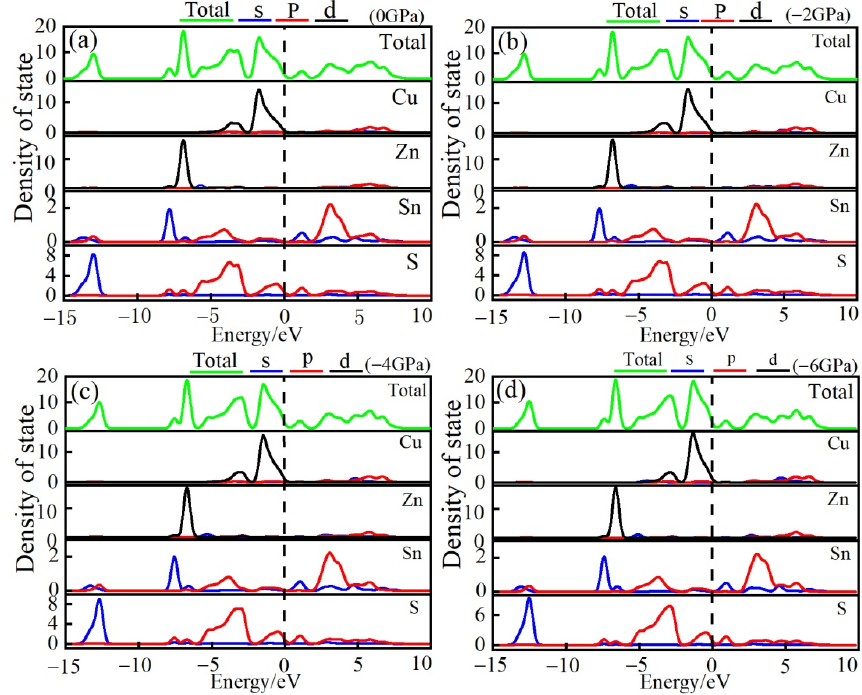
Figure 4. Cu 2 ZnSnS 4 density of states under tensile stress for ( a ) 0 GPa density of states and frac- tional density of states; ( b ) − 2 GPa density of states and fractional density of states; ( c ) − 4 GPa den- sity of states and fractional density of states; ( d ) − 6 GPa density of states and partial wave density of states.